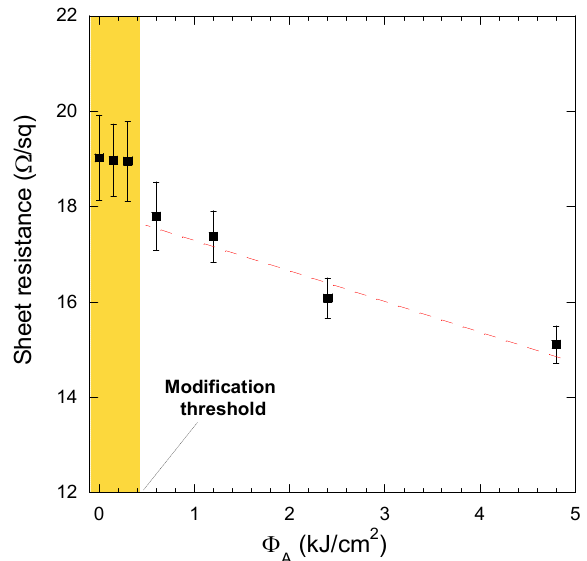
Figure 4. Sheet resistance of the carbon films as a function of the total accumulated laser fluence. Yellow box includes the measurements on the as-annealed untreated samples ( Φ A = 0) and those related to the two laser treatments ( Φ A = 0.15 kJ / cm 2 and Φ A = 0.3 kJ / cm 2 ) for which no appreciable modifications were observed from visual inspection. All displayed points result from an average of five measurements performed on different positions for each sample.